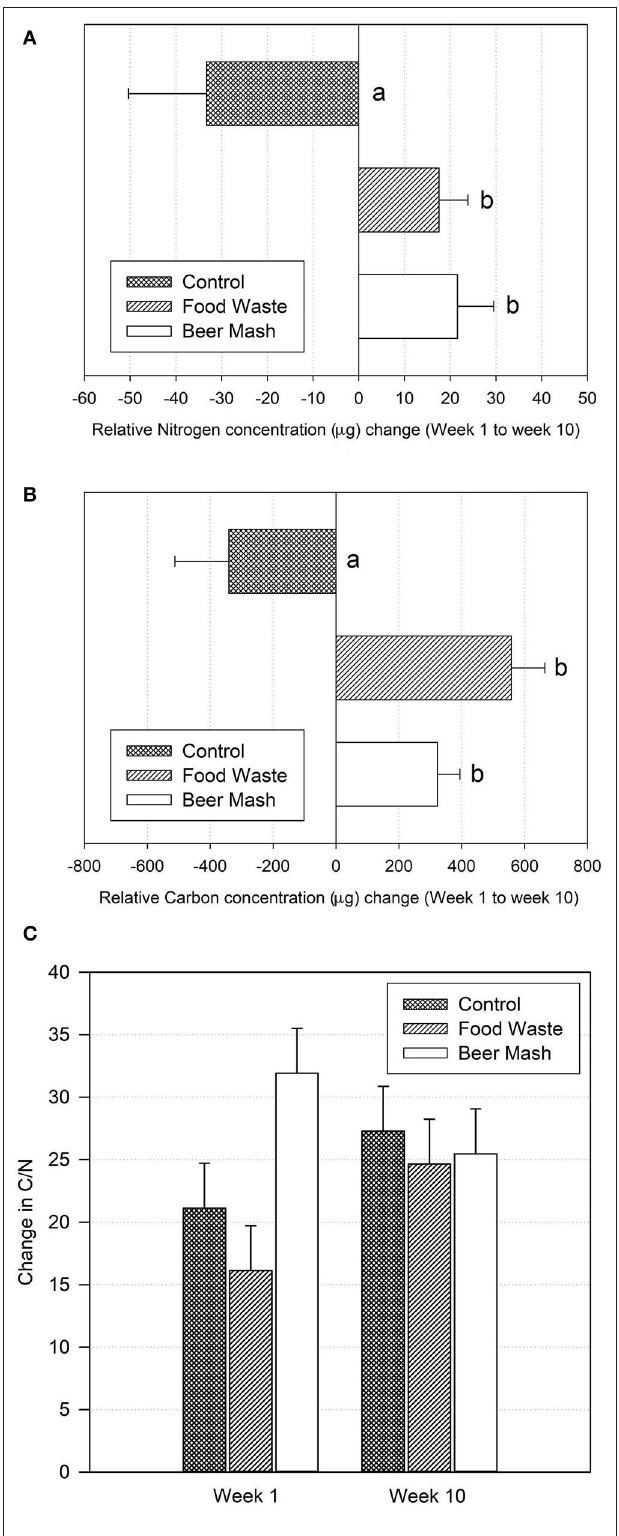
FIGURE 8 | (A) Total N, and (B) total C concentrations and (C) C:N ratio changes between week one and 10 in potting soil samples from different treatments as measured by elemental analysis. Treatments consisted of zero